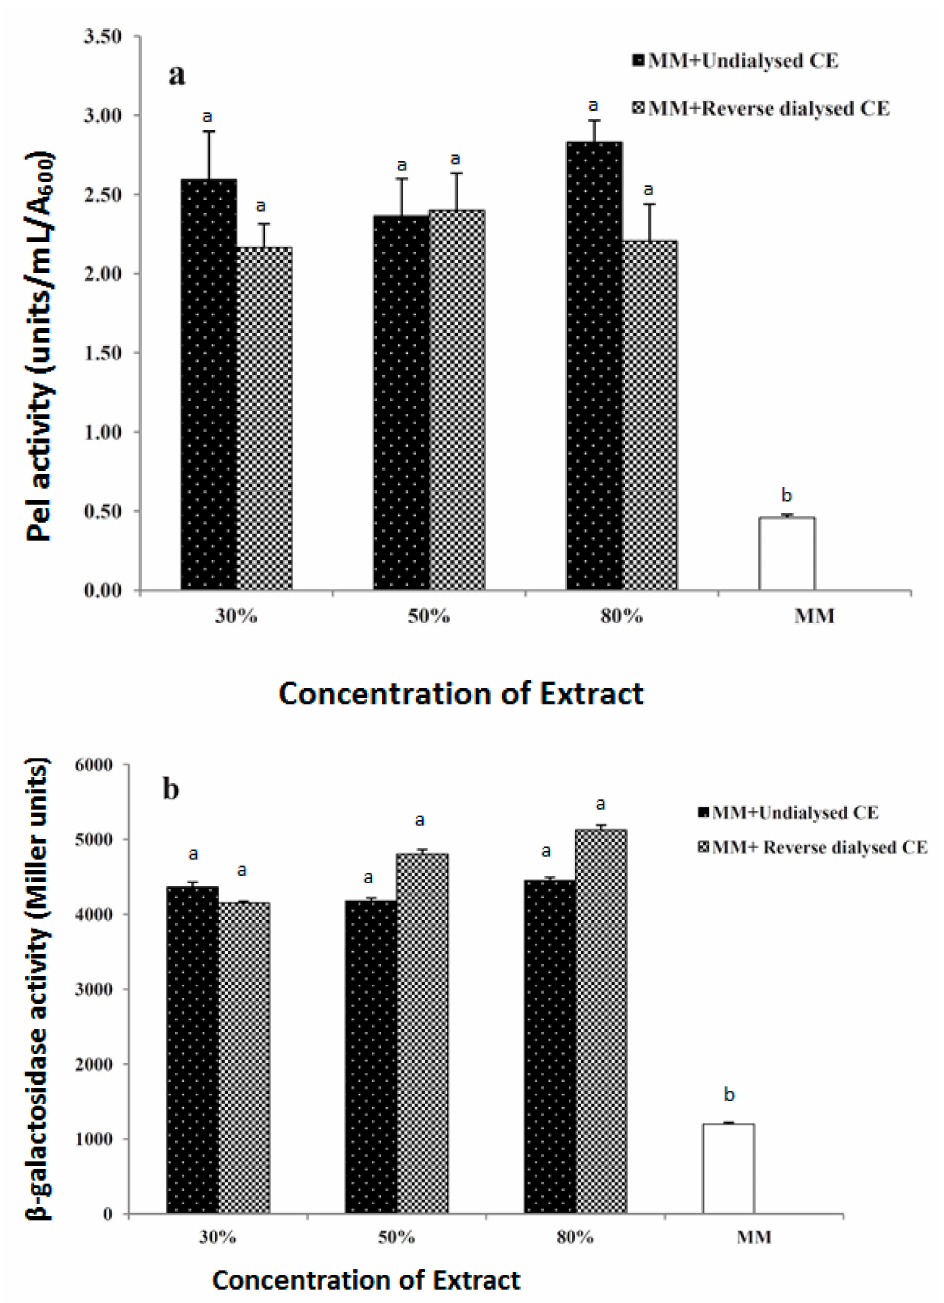
Figure 3. Pectate lyase ( a ) and β -galactosidase ( b ) activities in cultures of Pectobacterium strain KD100 carrying pel1-lacZ fusion. Bacteria were grown in MM medium supplemented with undialyzed or reverse dialyzed extract (RDE). Pectate lyase activity, expressed as units / mL / A 600 , and β -galactosidase activity, expressed in Miller units, were determined from culture supernatant and cells of the test strain, respectively. All experiments were performed in triplicate, and the mean values ± SD (indicated as error bars) are presented. Means with di ff erent letters are significantly di ff erent by Student’s t -test at P < 0.05. At all concentrations, the level of induction by both dialyzed and reverse dialyzed extracts were significantly higher than minimal